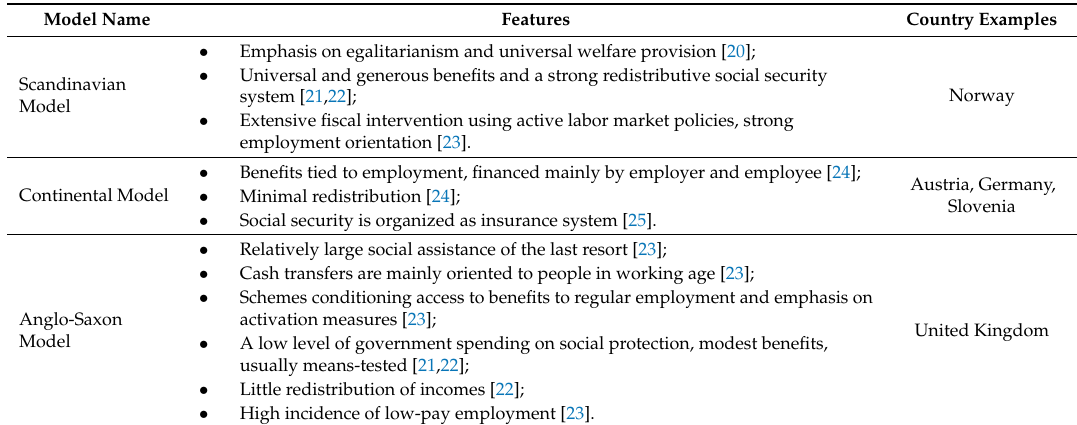
Table 1. Features of European welfare